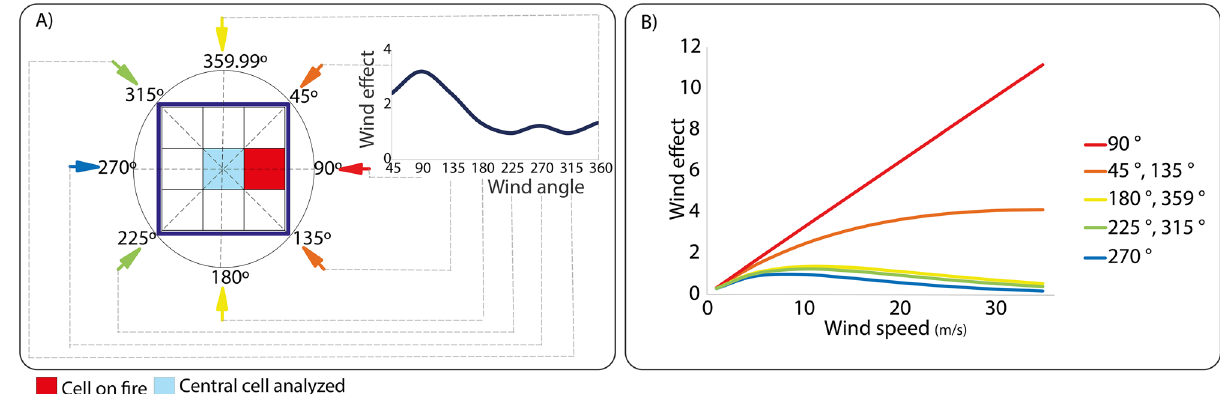
Figure 6. Effects of wind direction ( A ) and wind speed ( B ). In ( A ) the wind effect is a function of the wind angle in relation to the fire direction towards the central cell at a constant wind speed of 10 m/s. The wind effect due to wind speed at different direction angles is shown in ( B ). Red and orange colors indicate the wind directions that favor the propagation of fire towards the central cell (Eq. 2).